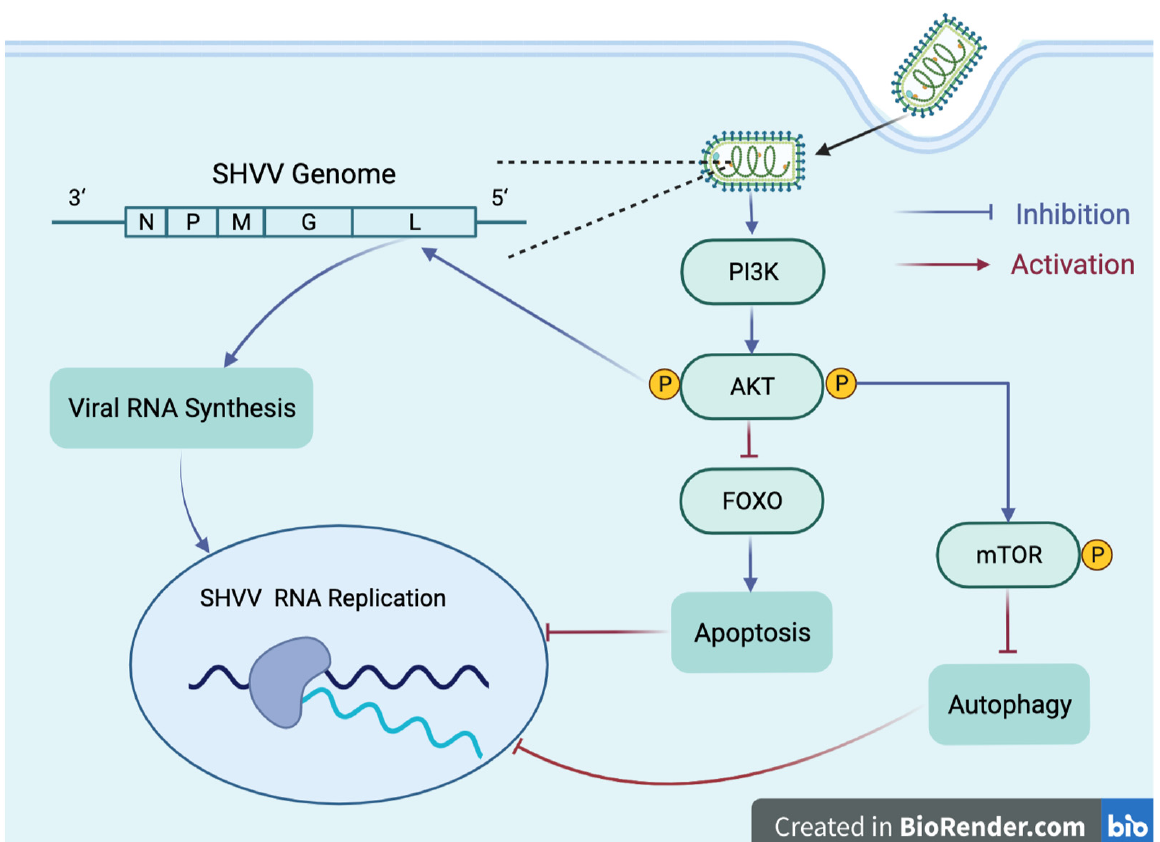
Figure 5 . A hypothesis for the involvement of AKT in SHVV replication. AKT is activated during virus infection and promotes virus replication via anti-apoptosis and inhibiting autophagy. AKT also participates in RNA synthesis of SHVV via activating the viral RNA-dependent RNA polymerase. The illustration was generated using BioRender (https://biorender.com/) (accessed on 26 June 2022).